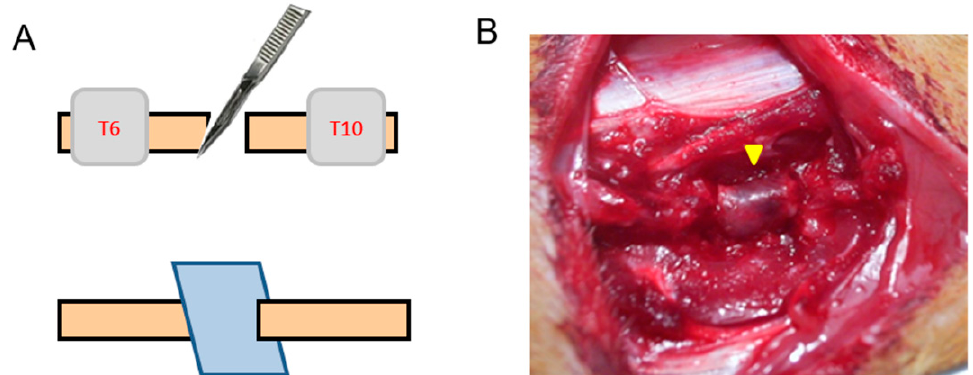
Figure 1. Rat spinal cord injury model. ( A ) An incision was made in the T8 of spinal cord, and the collagen scaffold (blue square) was inserted obliquely into the damaged area; ( B ) the position of implanted collagen scaffold in the T8 of spinal cord (yellow arrow).